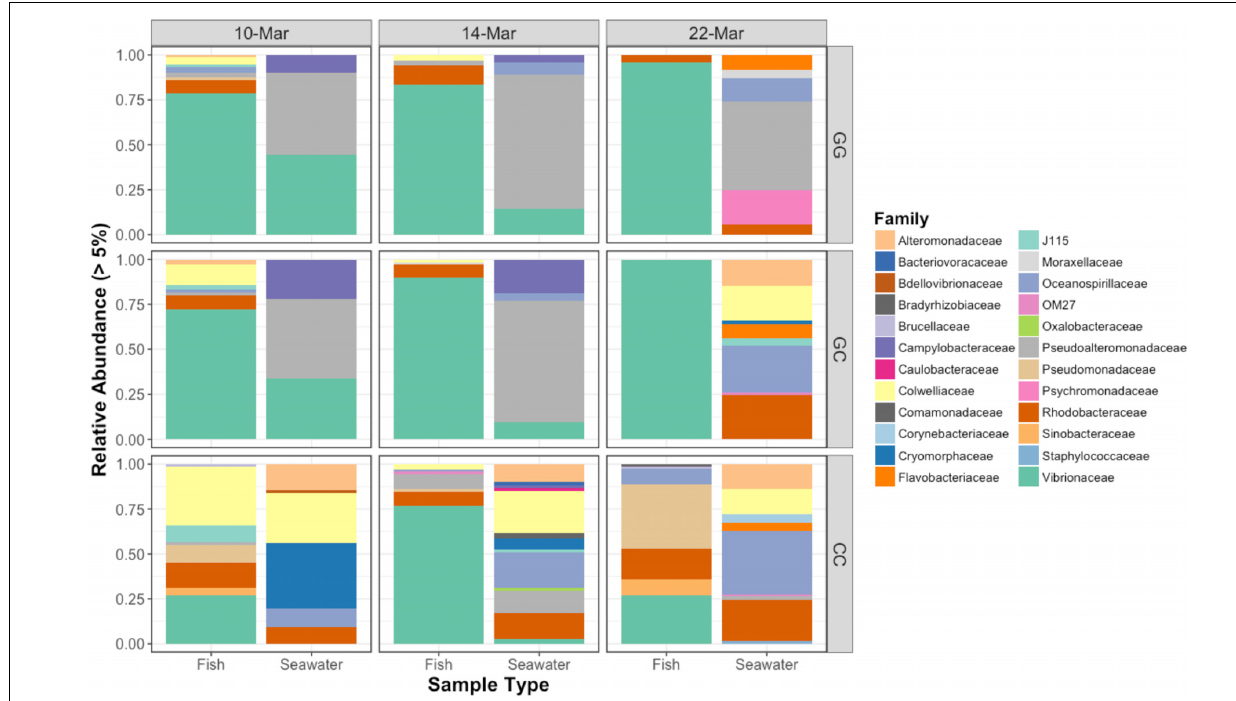
FIGURE 2 | Relative abundances of bacterial families that represent greater than 5% of the total community for fish and seawater samples. GG = greenwater, CC = claywater, and GC = greenwater-claywater treatment. Fish microbial communities were dominated by Vibrionaceae OTUs throughout the experiment, especially in the GG and GC